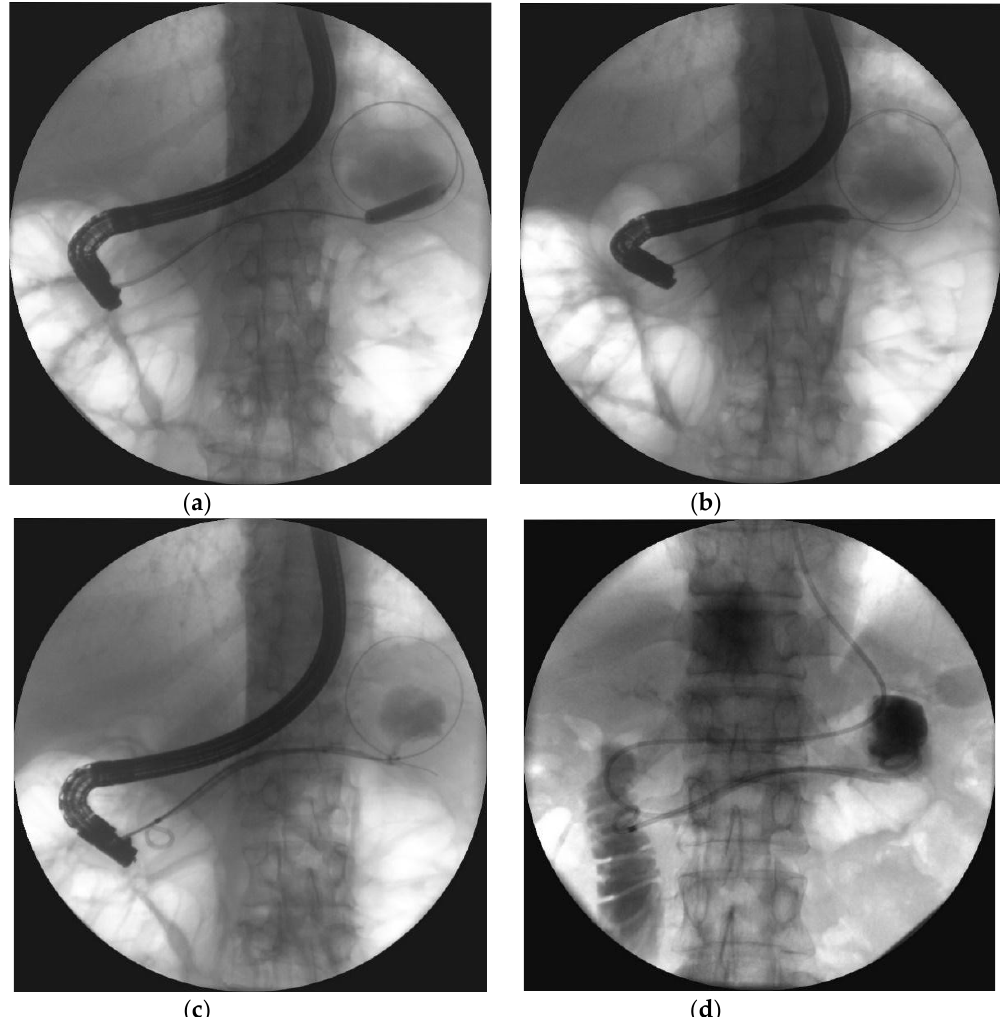
Figure 10. Endoscopic transpapillary drainage of symptomatic WOPN. ( a , b ) During ERP, the guide wire is introduced through the complete pancreatic duct disruption within the tail and looped within the central necrotic collection; the high-pressure 8-mm balloon is visible, which was used to dilate the pancreatic duct. ( c , d ) Transpapillary nasocystic catheter and stent insertion into the pancreatic duct, with the distal ends within the necrotic collection; contrast agent was administered through the catheter, filled up the collection, and drained freely into the duodenum.